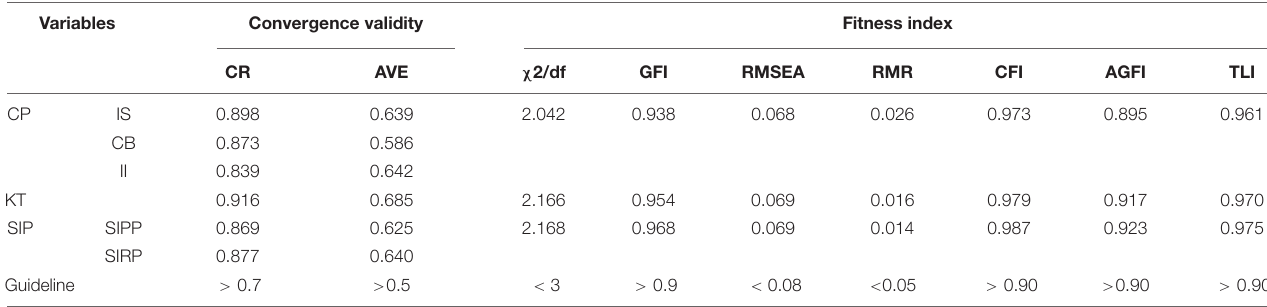
TABLE 2 | Confirmatory factor analysis